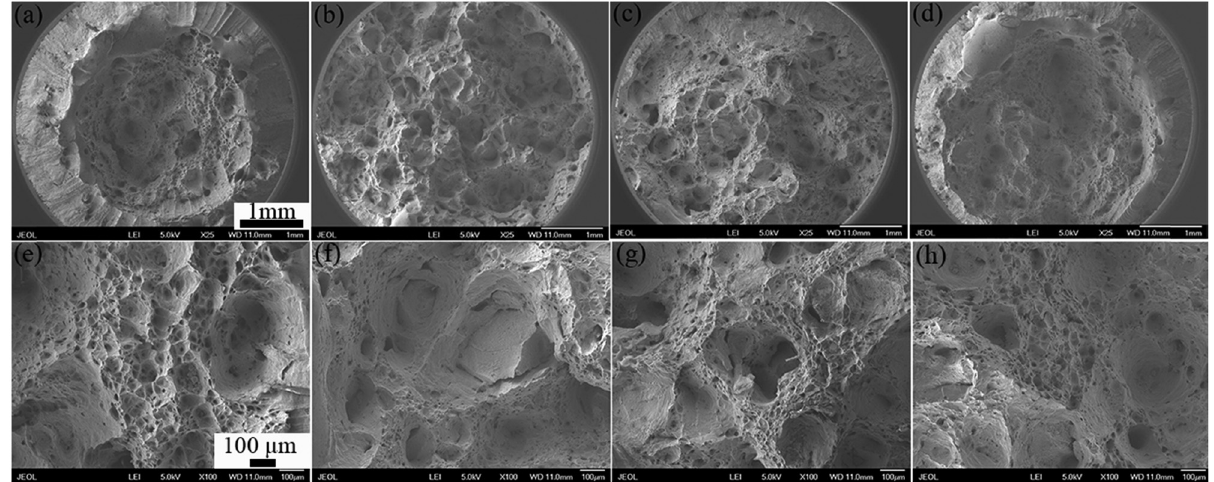
Figure 5: Fractures surface morphology at 750°C with a strain rate of 0.005 s − 1 observed by SEM: ( a and e ) steel 1#; ( b and f ) steel 2#; ( c and g ) steel 3#; ( d and h ) steel